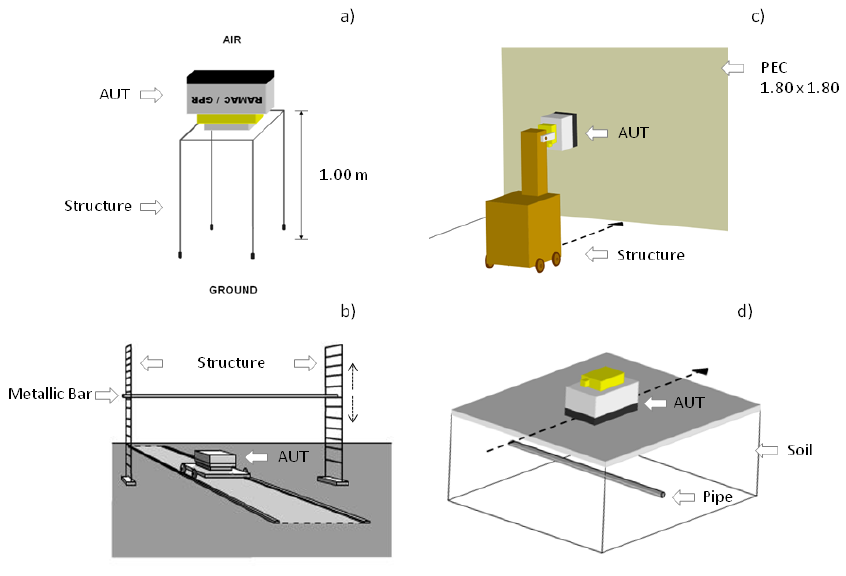
Figure 5 . Experimental setups used to obtain: (a) the direct signal between dipoles in a reflector-free environment, (b) the emitted wavelet in air reflected in a metallic bar at different distances, (c) the emitted wavelet in air reflected in a PEC at different distances and (d) the emitted wavelet in a lossy dielectric reflected in a large buried